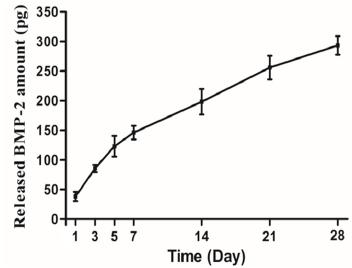
Figure 4. In vitro release kinetics of recombinant human bone morphogenetic protein-2 (rhBMP-2).